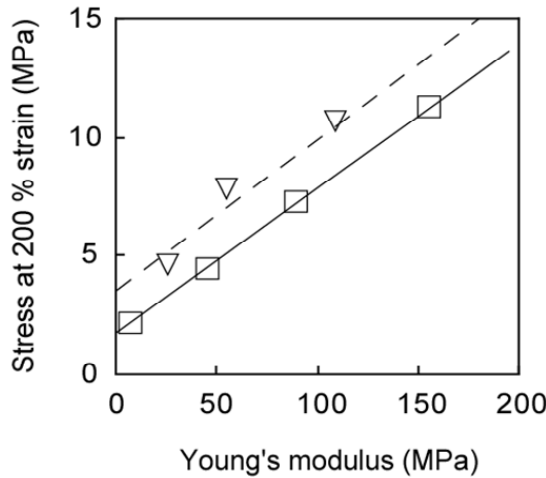
Figure 10. Relationship between Young’s modulus and stress at 200% strain of PHS/M-6 ( □ ) and PHS/M-16 ( ▽ ) with various monomer